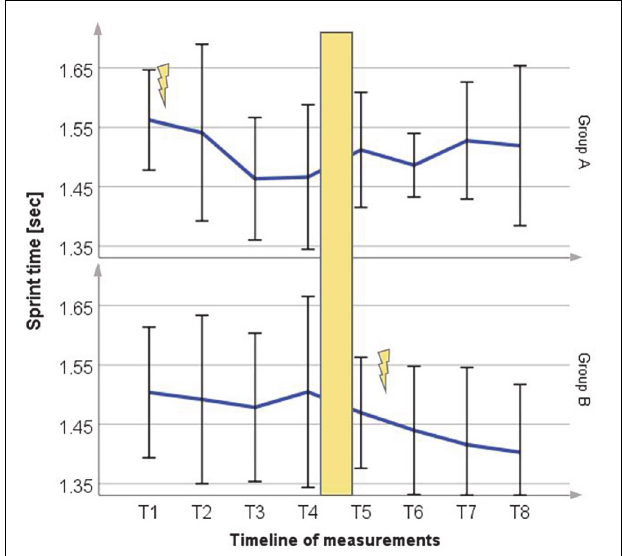
FIGURE 2 | Mean ( ± SD) change in jump power for Group A period 1 and Group B period 2, compared to each control group ( p = 0.04). Lightning bolt represents each respective WB-EMS period; yellow area = wash-out phase.